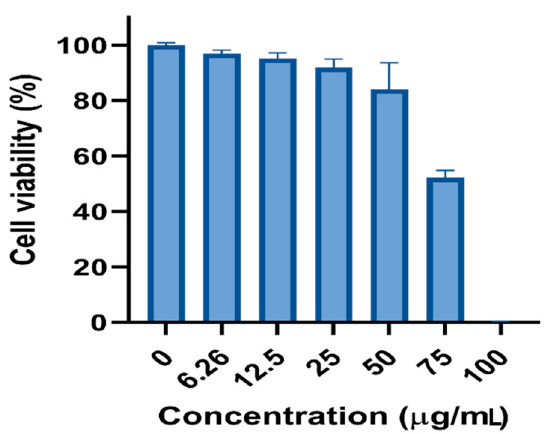
Figure 13. Effect of O-AgNPs on the viability of LoVo cancer cell lines. Bar graph showing dose relationship of O-AgNPs and the cell viability (%).